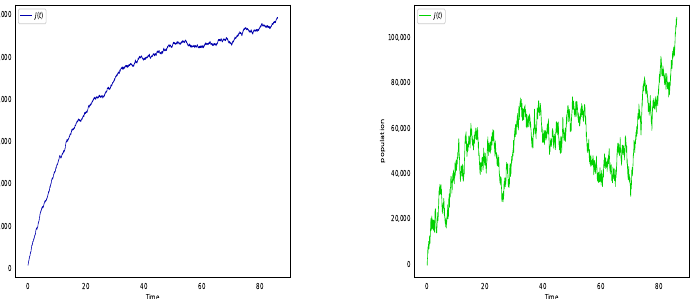
Figure 1. The numbers of diagnosed case with different noises. In particular, α 1 = 0.09, α 2 = 0.07 in ( left ) and α 1 = 0.95, α 2 = 0.95 in ( right ). It depicts that fluctuation is getting smaller with the decrease of the